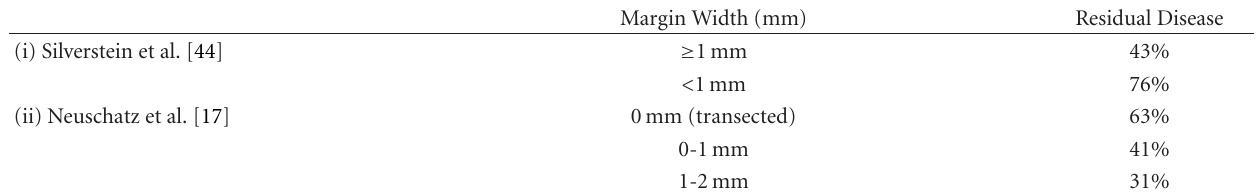
Table 6: Reexcision specimens analysis in patients treated with lumpectomy for